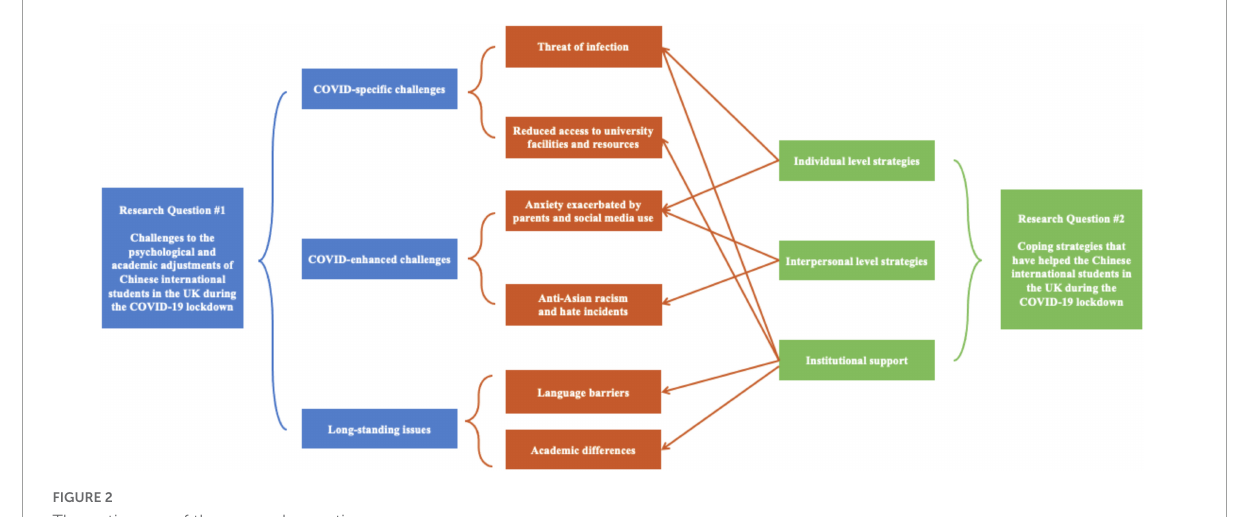
FIGURE2 Thematic map of the research